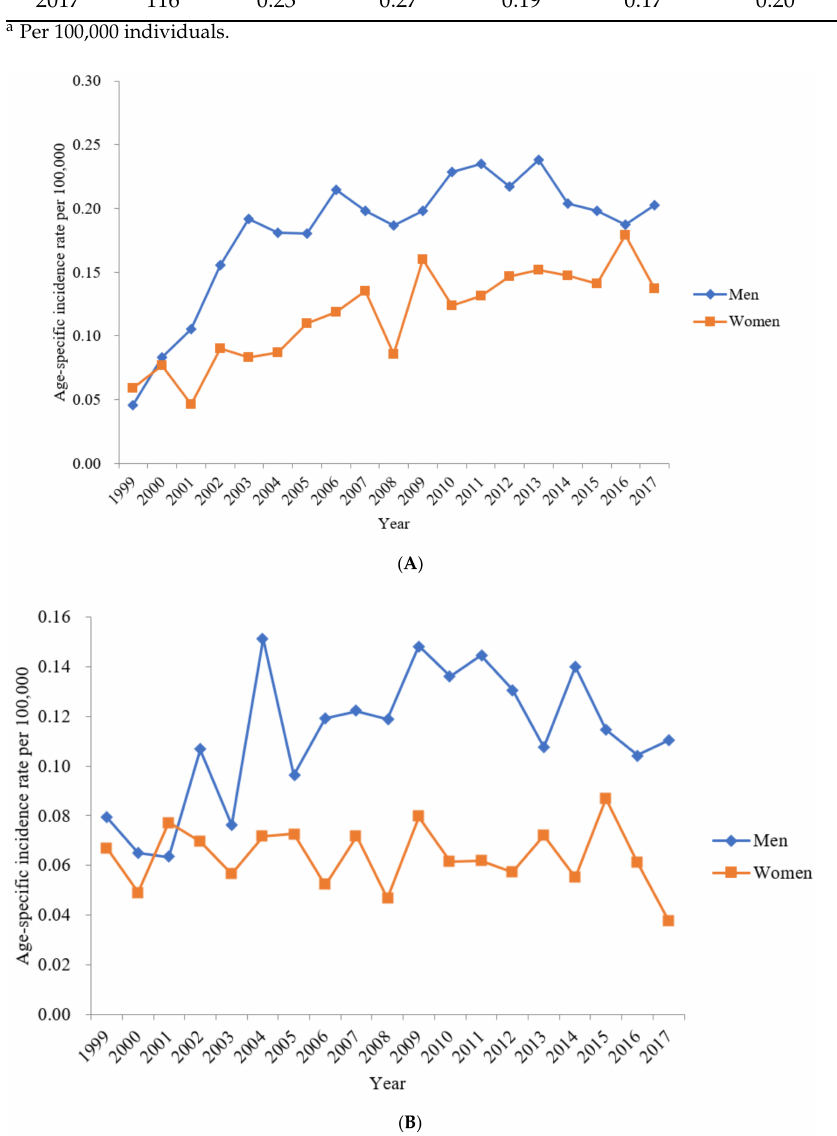
Figure 1. The age-standardized incidence rate of colon and rectum signet-ring cell carcinoma. ( A ) The age-standardized incidence rate of colon signet-ring cell carcinoma per 100,000 individuals between 1999 and 2017. ( B ) The age-standardized incidence rate of rectum signet-ring cell carcinoma per 100,000 individuals between 1999 and